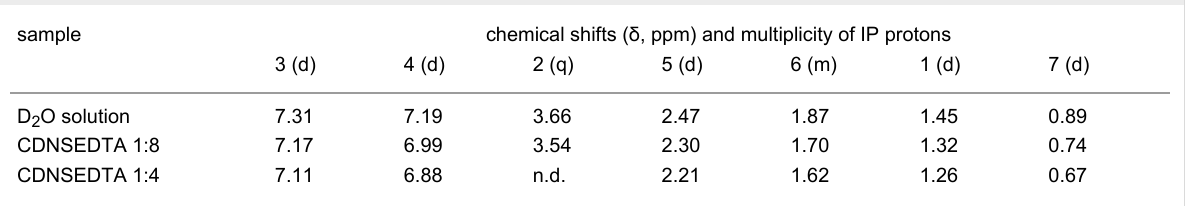
Table 1: Chemical shift ( δ ) of IP dissolved in D 2 O solution, and confined in CDNSEDTA (1:4) and CDNSEDTA (1:8).